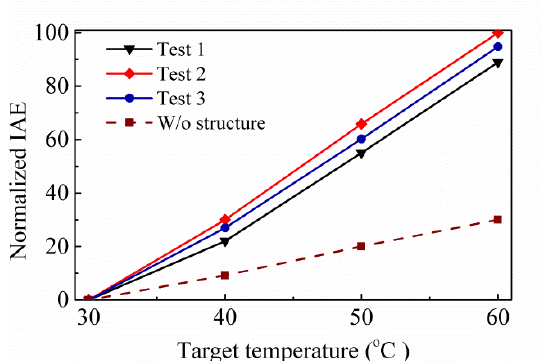
Figure 6. Variances of the IRA with di ff erent w x and w y for the thermopiles with various SA-SRHA w x of 15, 15.5, and 16 µ m.